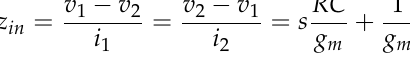
Figure 15. Block diagram showing the synthesis of the floating series inductance-resistance simu- lator.